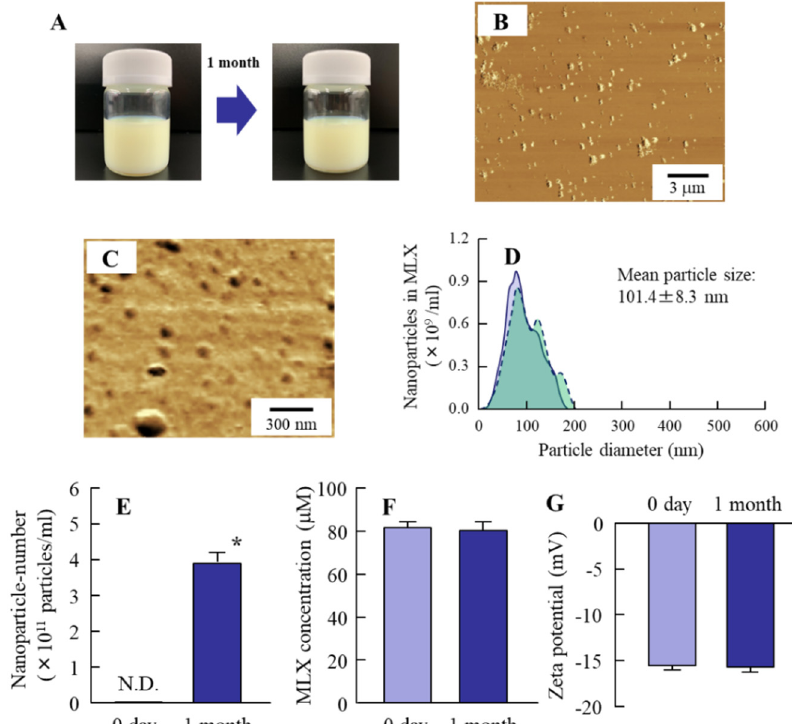
Figure 2. Stability of MLX-NPs 1 month after preparation. ( A ) Photographs of MLX-NPs at the time of preparation and 1 month after. ( B ) and ( C ), AFM images of MLX-NPs 1 month after preparation in wide- ( B ) and narrow-fields ( C ). ( D ), particle frequency of MLX nanoparticles in MLX-NPs